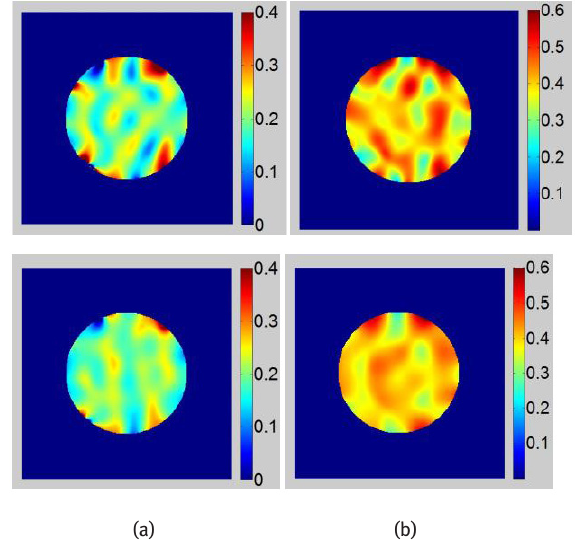
Figure 6: Strain maps obtained with noisy images, Top: Strain maps obtained with original image, Bottom: Strain maps obtained after DC component subtraction, (a). E